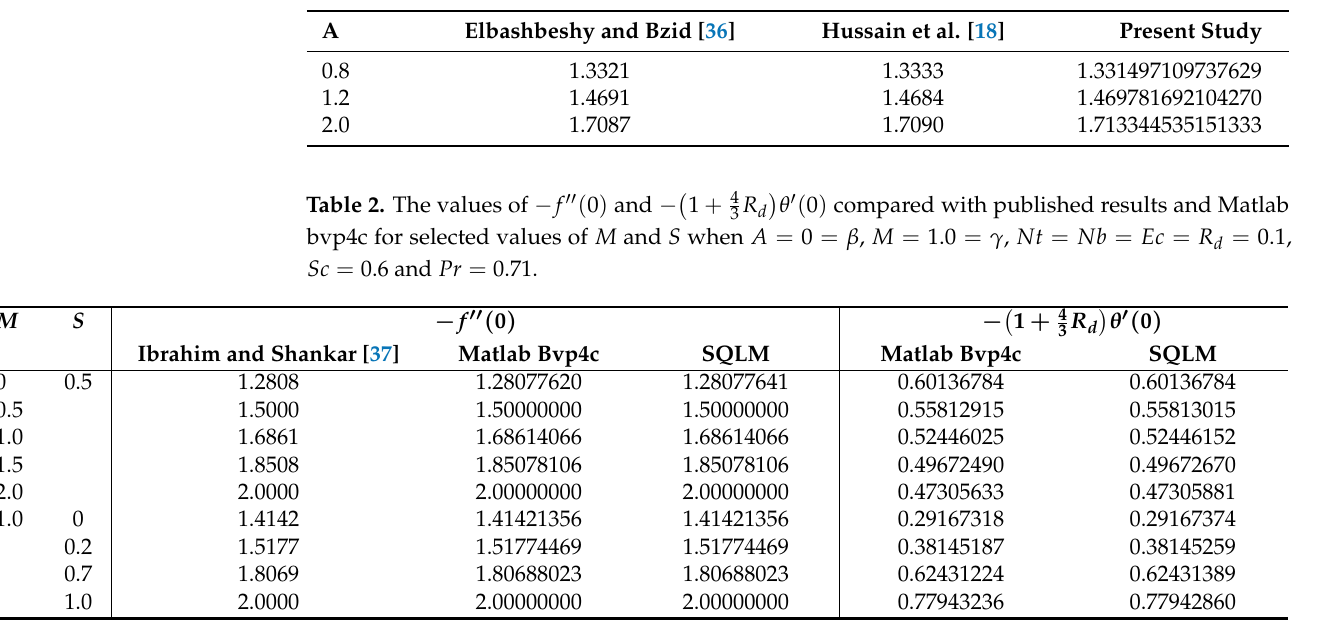
Table 1. The values of − f (cid:48)(cid:48) ( 0 ) compared with published results for selected values of A . A Elbashbeshy and Bzid [36] Hussain et al. [18] Present Study 0.8